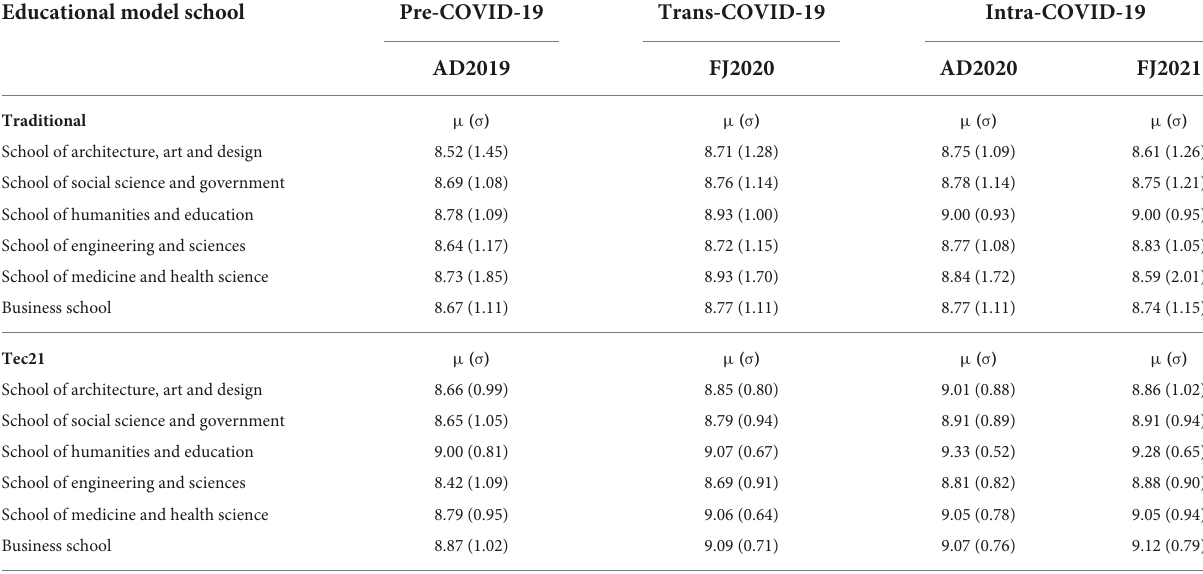
TABLE 2 Average evaluation by educational model and school along the different COVID-19 periods and standard deviation in parenthesis.